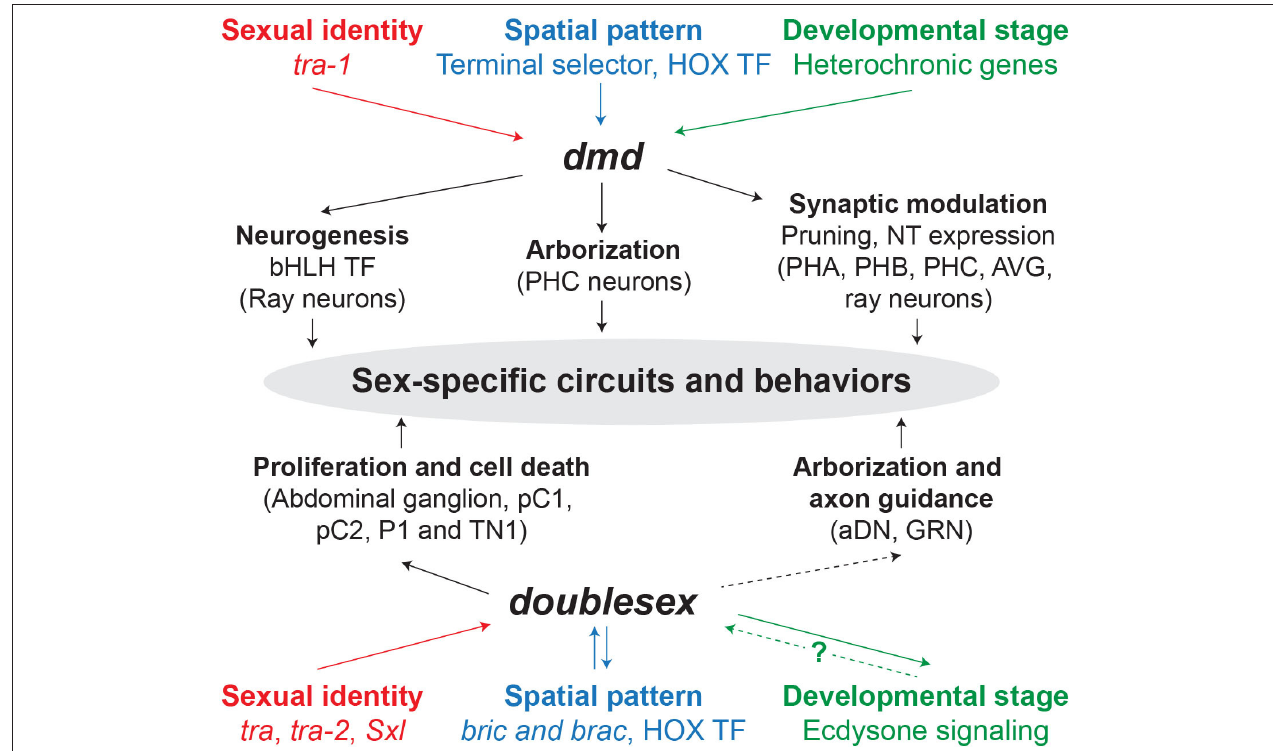
FIGURE 2 | dmd and doublesex mechanisms underlying sex-specific circuits and behaviors. Solid and dashed arrows indicate direct and indirect regulation, respectively. The question mark represents that the mechanism by which ecdysone signaling regulates dsx is unknown. TF, transcription factor; NT,